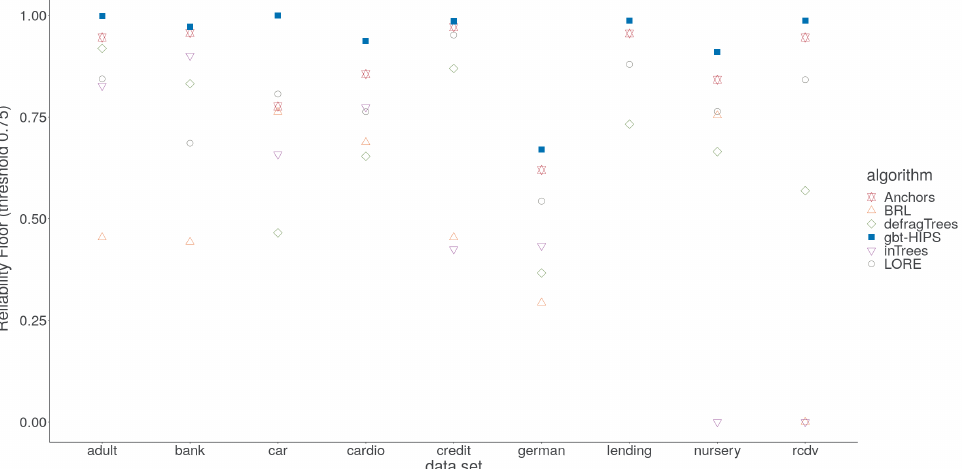
Figure 7. 0.75 reliability floor for stochastic GBT model